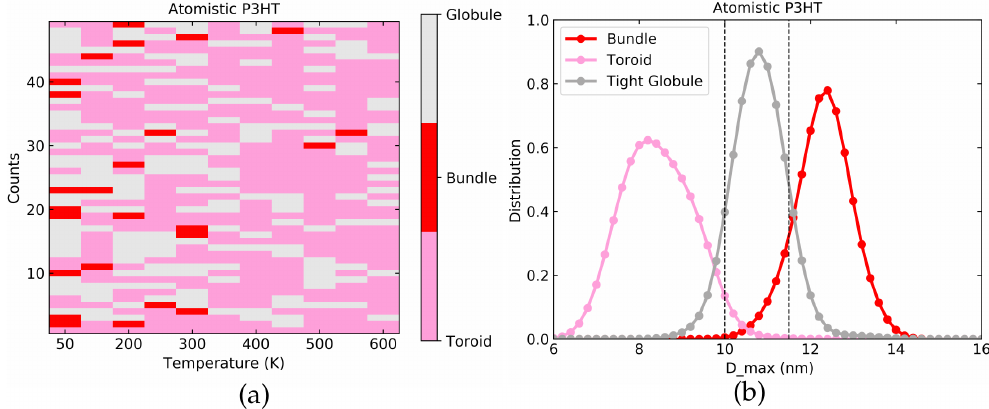
Figure 6. ( a ) Color coded final conformations at a range of temperature for 50 simulations for atomistic P3HT in vacuum. ( b ) D max distributions used for toroid, globules, and bundles.